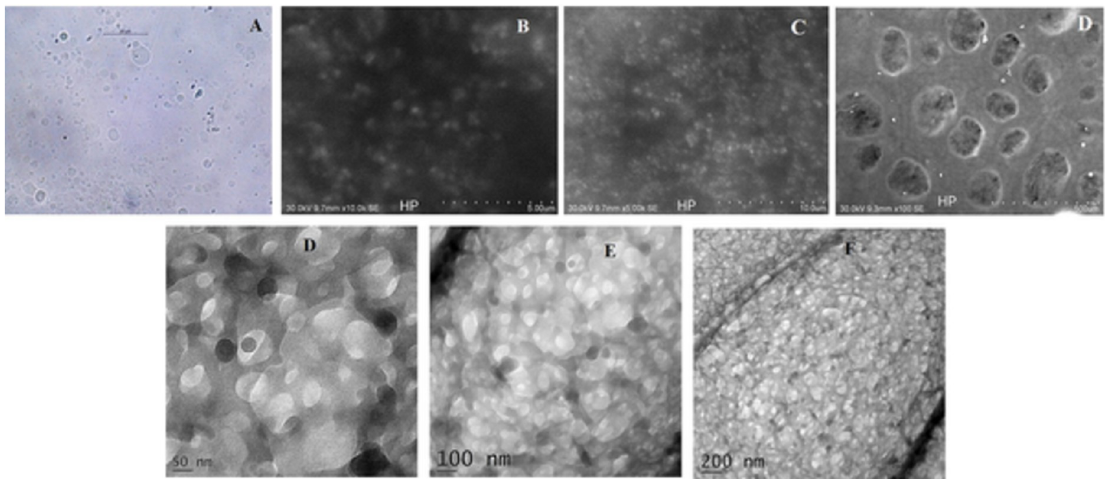
Fig 4. Photomicroscopic images of HTN (A), SEM images of HTN (B and C), and TEM images of HTN (D and E).